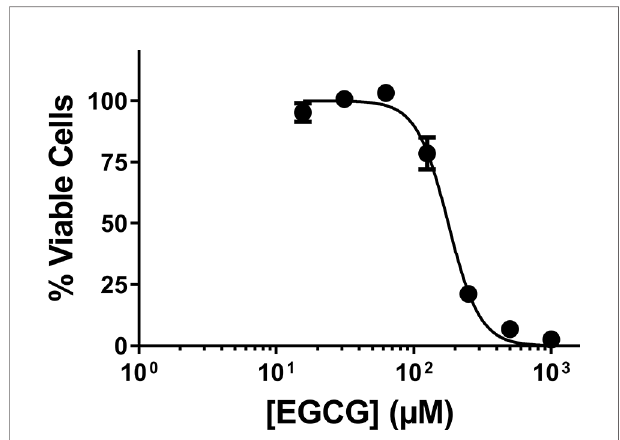
FIGURE 1 | Effect of EGCG on Leishmania infantum . Promastigotes of L. infantum were cultivated in Schneider ’ s Drosophila medium at 26°C for 72 h in the absence or presence of EGCG (0.015 – 1 mM). Cell viability was measured using the alamar Blue assay. In the control (absence of EGCG), the same volume of PBS (solvent of EGCG) was added to the growth medium of controls. Values represent mean ± standard error of three different